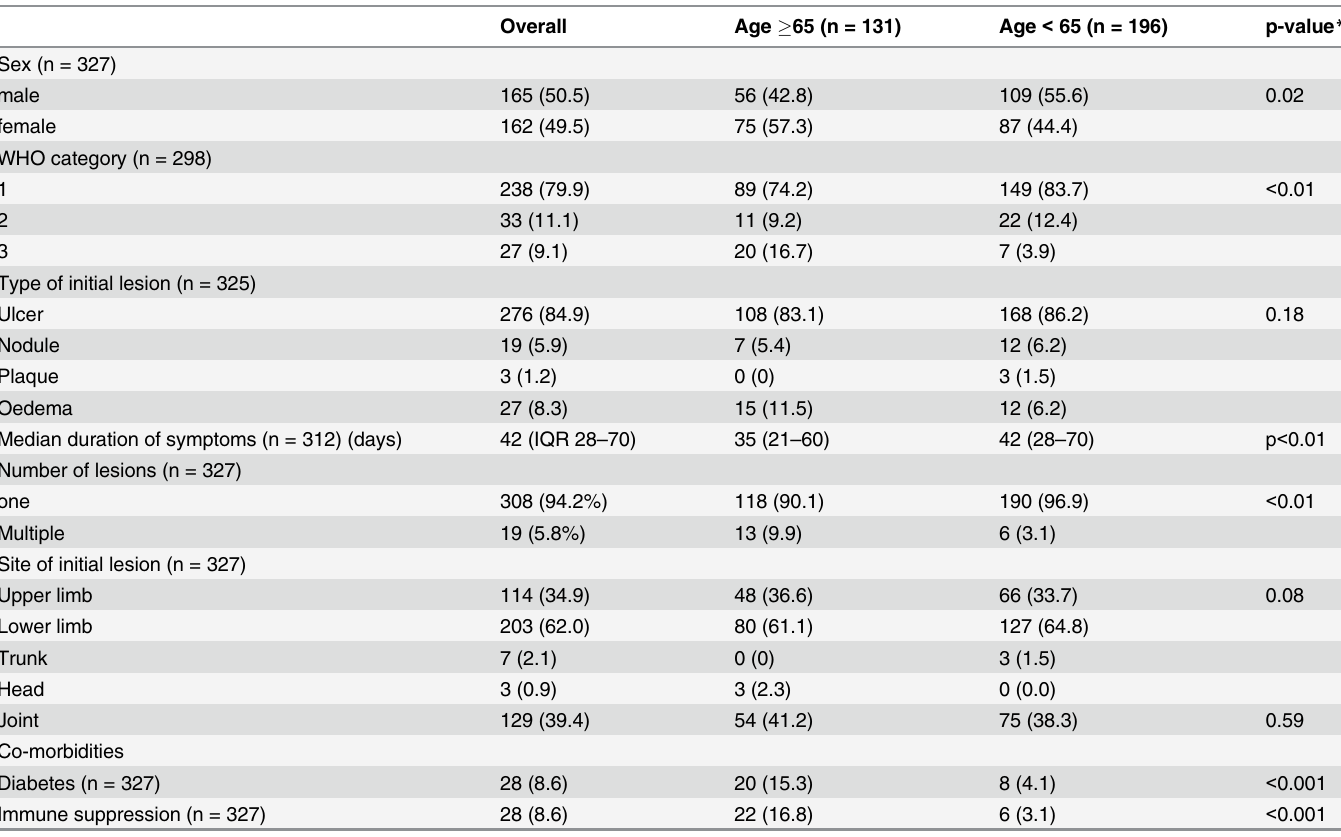
Table 1. Baseline patient characteristics stratified by age-group. Overall Age (cid:1) 65 (n = 131) Age < 65 (n = 196) p-value